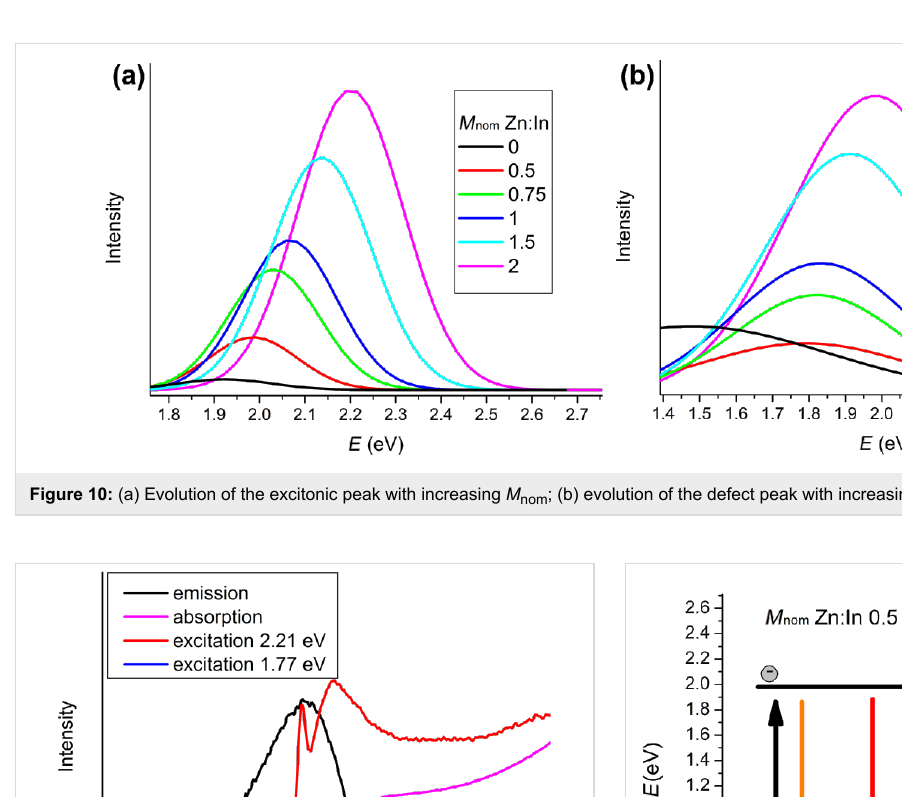
Figure 9: PL spectra of (a) non-doped QDs and (b) one of the doped QDs deconvoluted into energy coordinates by using two Gaussian functions.